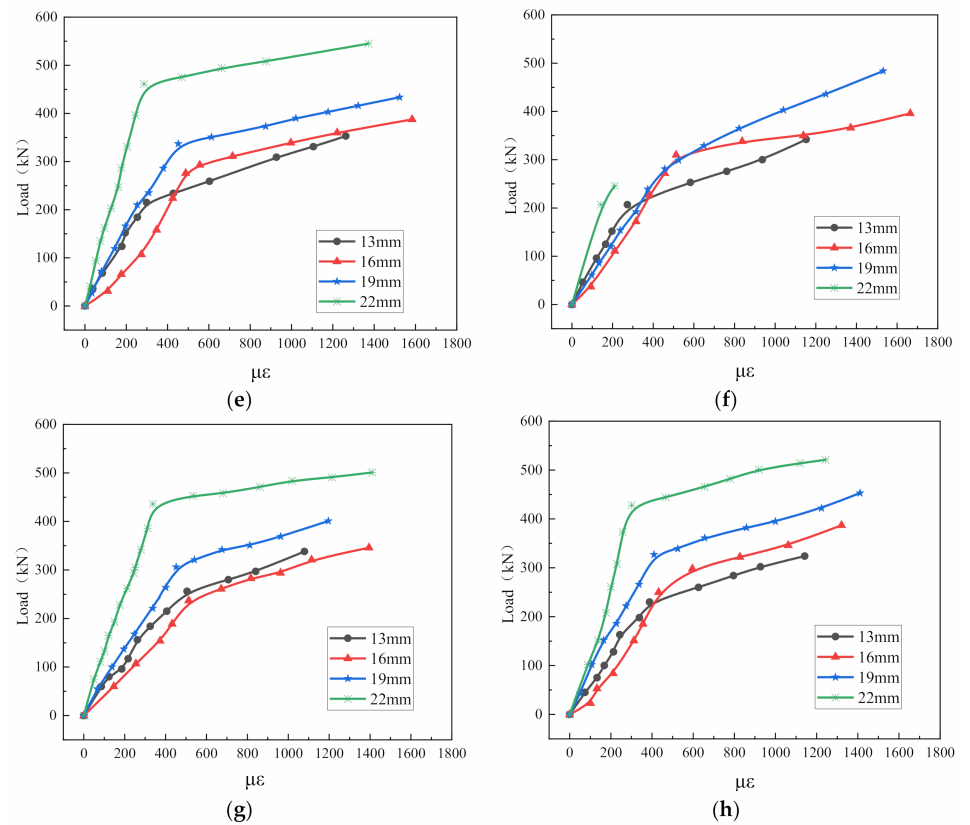
Figure 7. Stud load–strain curve: ( a ) 13 mm diameter peg; ( b ) 16 mm diameter peg; ( c ) 19 mm diameter pegs; ( d ) 22 mm diameter peg; ( e ) 100 mm spacing, 28 mm length studs; ( f ) 100 mm spacing, 35 mm length studs; ( g ) 150 mm spacing, 28 mm length studs; ( h ) 150 mm spacing, 35 mm length